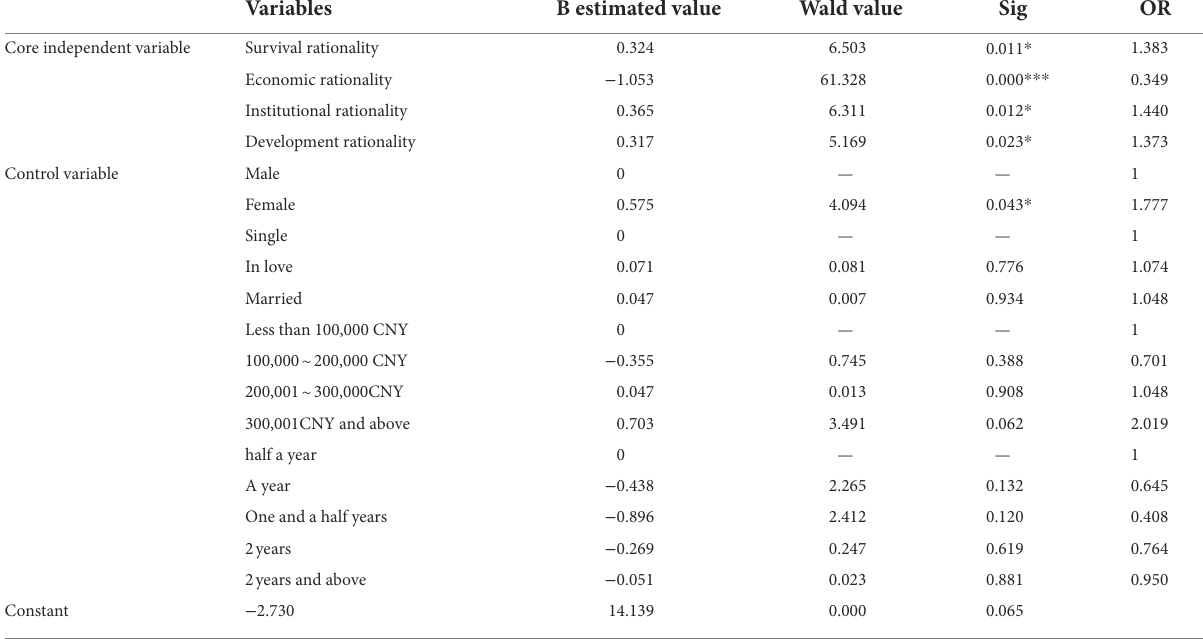
TABLE 7 Binary logistic regression results of the impact of various dimensions on the return choice of overseas students in the United Kingdom.